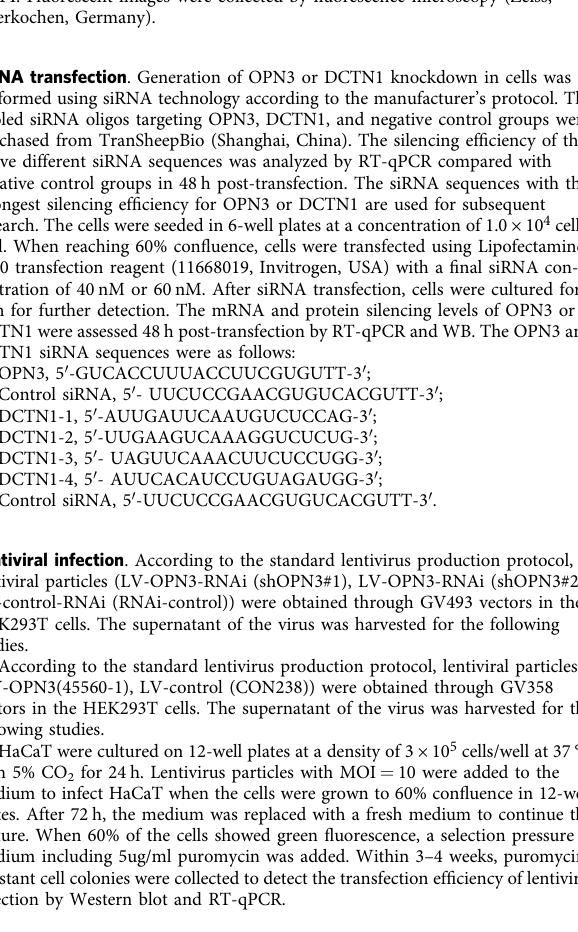
(A0423; Beyotime); and rabbit anti-human DCTN1 polyclonal antibody (AB_2838577, Af fi nity Biosciences, Ltd.) conjugated to Alexa Fluor 488-labeled goat anti-rabbit IgG (A0423; Beyotime). Nuclear staining was performed with DAPI. Fluorescent images were collected by fl uorescence microscopy